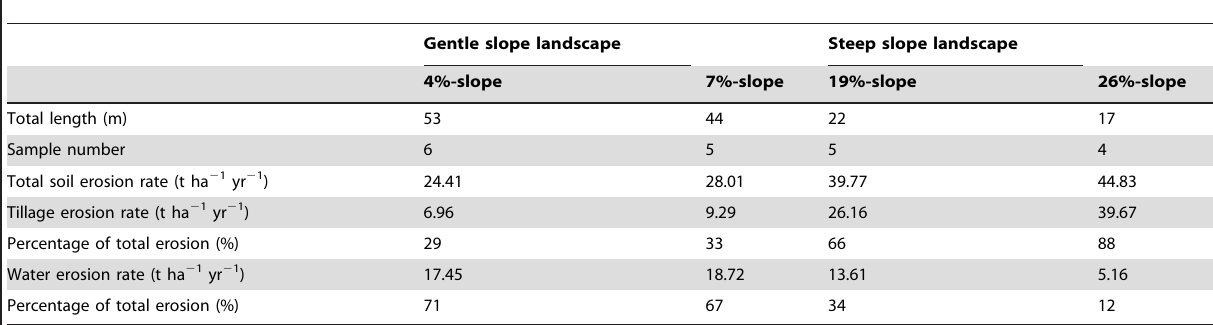
Table 1. Total soil erosion rates, tillage erosion rates and water erosion rates.